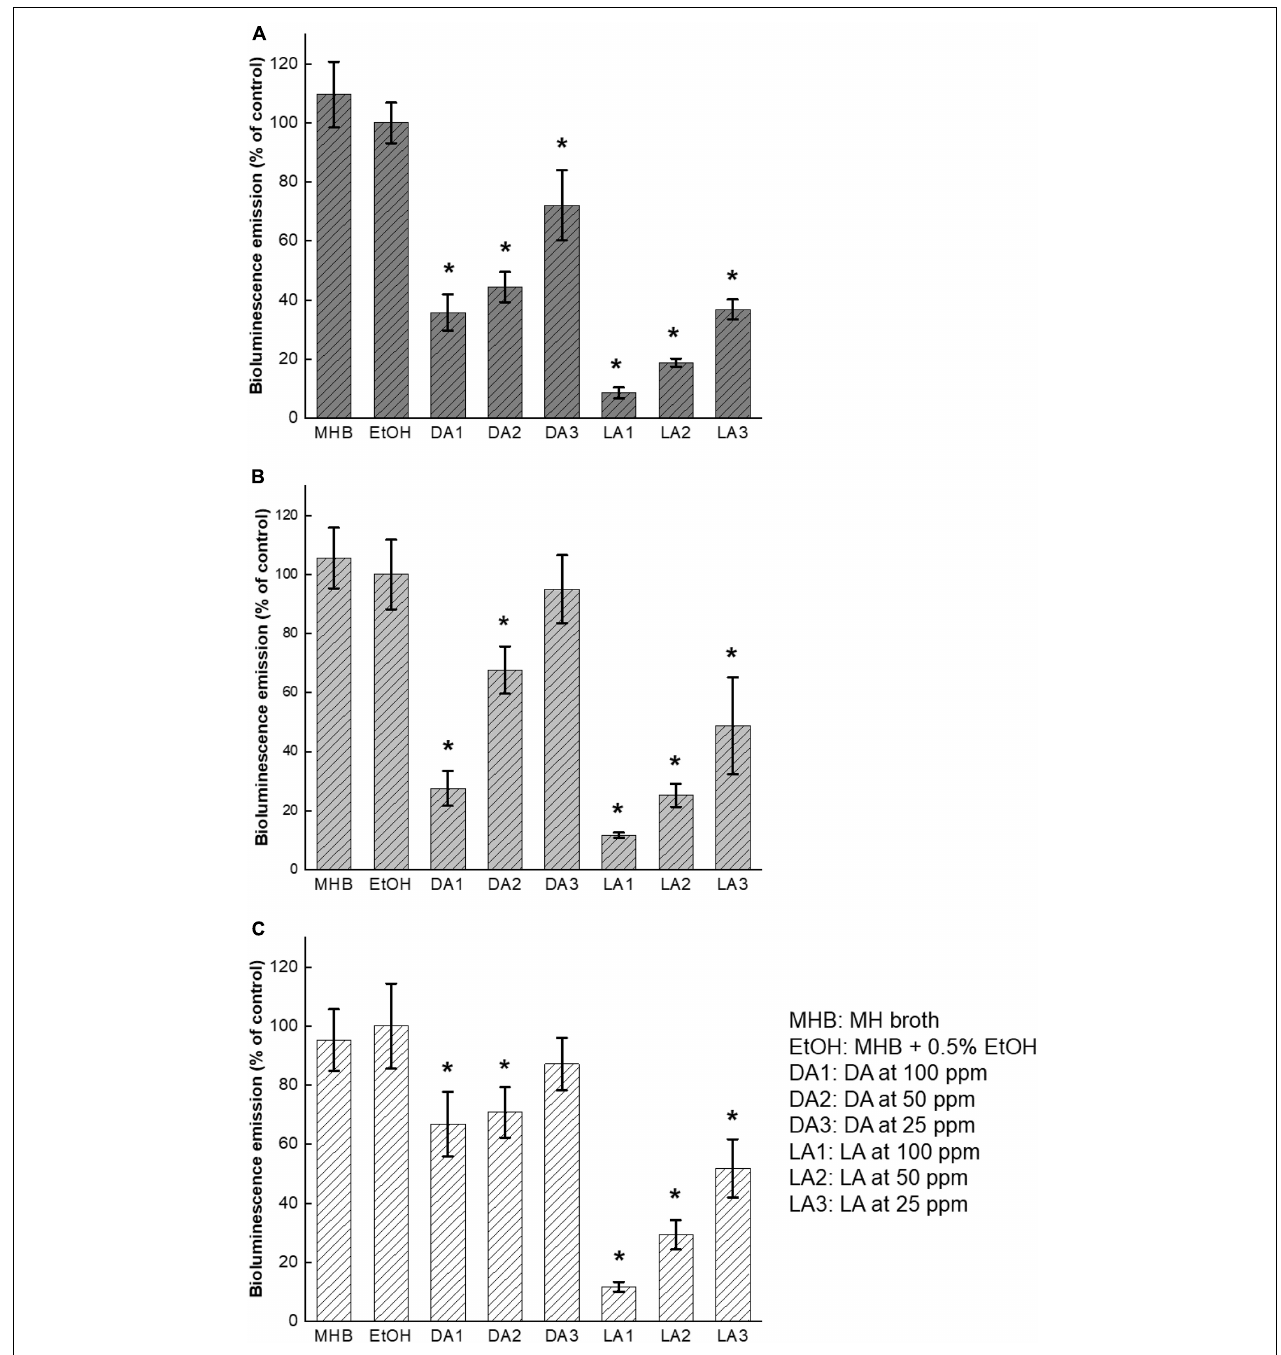
FIGURE 3 | Influence of decanoic acid (DA) and lauric acid (L.A.) on AI-2 activity in C. jejuni cell-free supernatants. C. jejuni strain F38011 (A) , NCTC11168 (B) , and ATCC33560 (C) . Cell-free supernatant from each C. jejuni culture grown in MH broth was incubated with fatty acids for 1 h, respectively. MH broth containing 0.5% ethanol was used as ethanol control. MHB is the broth control and EtOH is the negative control. Bioluminescence level of the negative control was set at 100%. Bioluminescence emission of each treatment was normalized to the control. Three biological replicates were performed. * Statistical significance between negative control and treated samples was determined by one-way ANOVA coupled with Dunnett’s multiple comparisons test ( P < 0.05 was considered statistically significant).